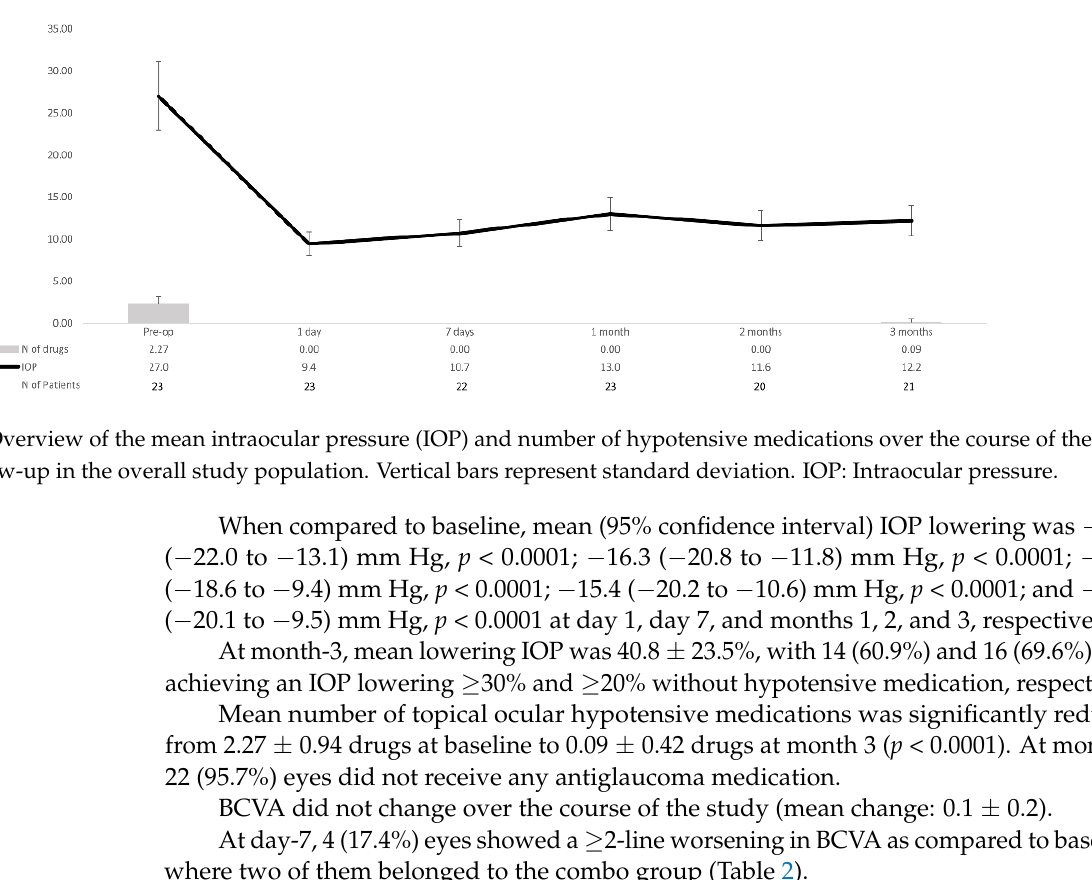
Table 2. Overview of the number (%) of patients who experienced changes in best corrected visual acuity throughout the study.